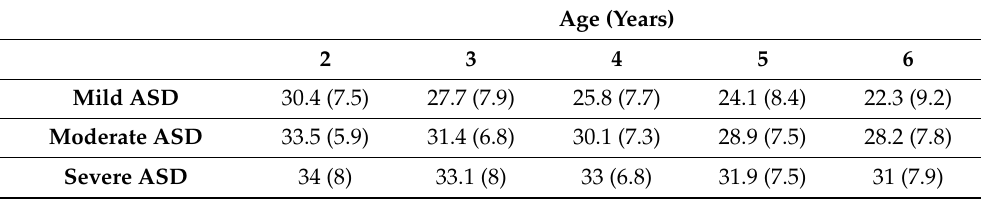
Table 2. Averaged Combinatorial Receptive Language score (assessed by MSEC) for the mild, moderate, and severe ASD groups. A lower score indicates symptom improvement. The data are presented as the mean (SD).